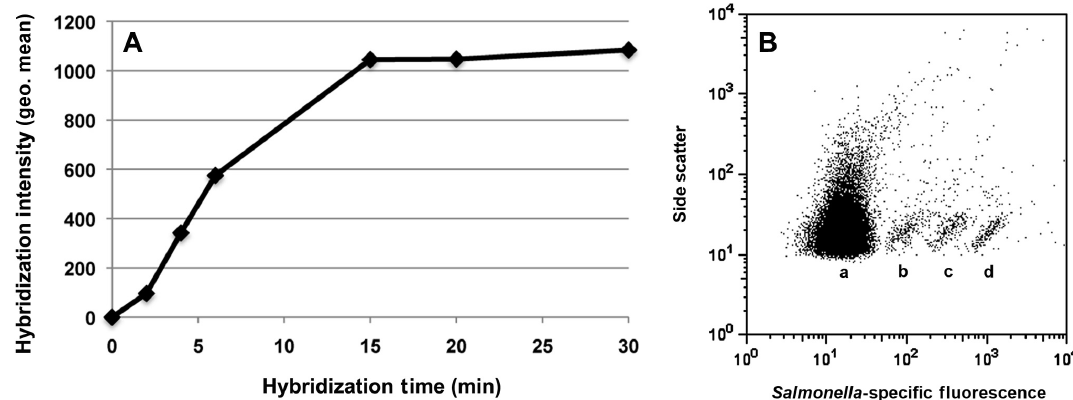
Figure 5 . Hybridization signal and separation as a function of time for Salmonella Typhimurium subpopulations in contaminated alfalfa sprouts. Alfalfa sprouts were spiked with 10 6 CFU g (cid:1) 1 S. Typhimurium, treated for 30 min with 5 (cid:1) Denhardt ’ s solution, fi xed for 30 min with 10% buffered formalin and hybridized using the Sal3/Salm-63 probe cocktail. Panel A: An elliptical gate was drawn around the emerging subpopulation of stained S. Typhimurium cells at each timepoint and the geometric mean signal intensity (GMSI) was calcu- lated. As indicated by the graph, near – maximal staining intensity was achieved after 15 min hybridization. Panel B: Dot plot shows an overlay of data obtained after 2, 4 and 15 min hybridization for contaminated sprouts (10 6 CFU g (cid:1) 1 S. Typhimurium, as above). Non- target microbiota (subpopulation a) remained unstained at all timepoints. Subpopulations b, c and d are S. Typhimurium after 2, 4 and 15 min hybridization, respectively. Although the signal intensity at 2 min was only ∼ 8.5% that of target cells hybridized for 30 min, the Salmonella subpopulation at this timepoint was clearly distinguishable from the non-target background. These data suggest that while maximal staining may require longer hybridization, effective detection of Salmonella may be accomplished at earlier hybridization